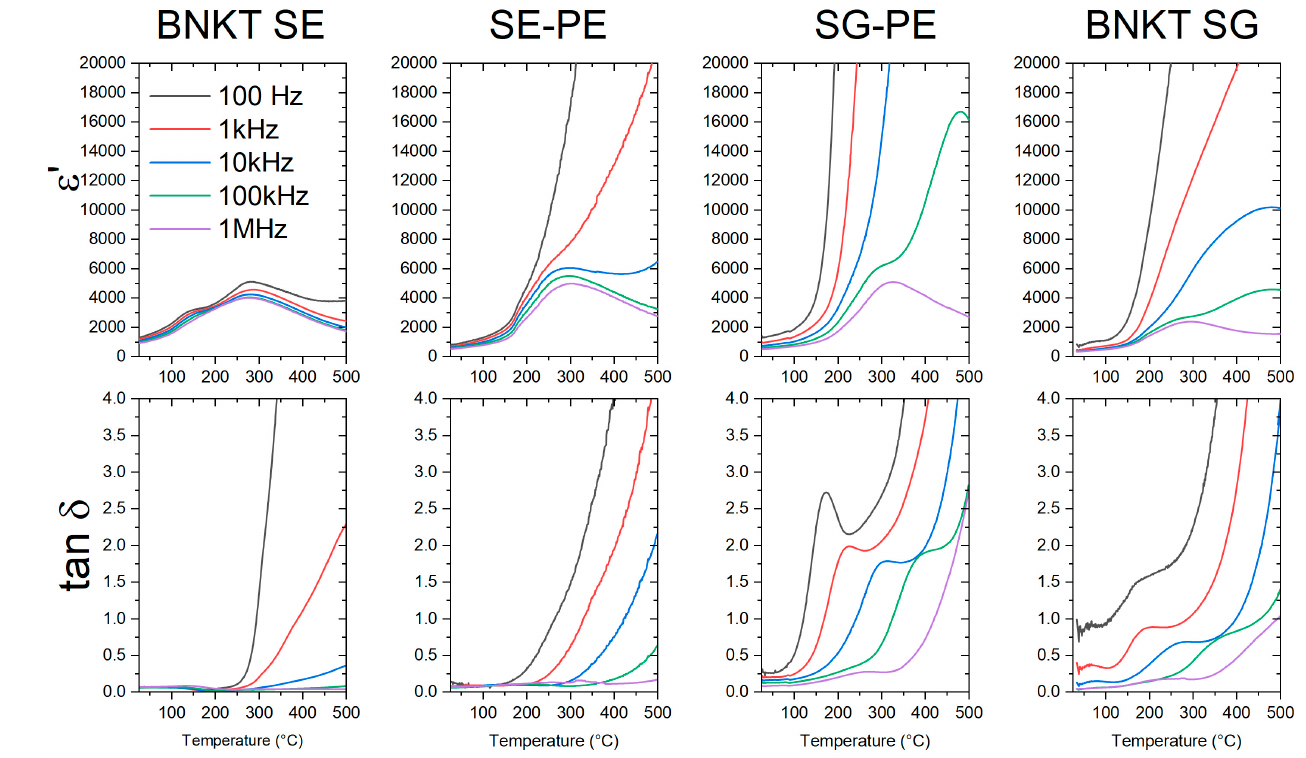
Figure 6. Real permittivity ( ε′ ) and loss tangent (tan δ ) vs. temperature curves at di ff erent frequencies of BNKT (SS and SG), and 95BNKT-5NCF (SS-PE and SG-PE) sintered samples.